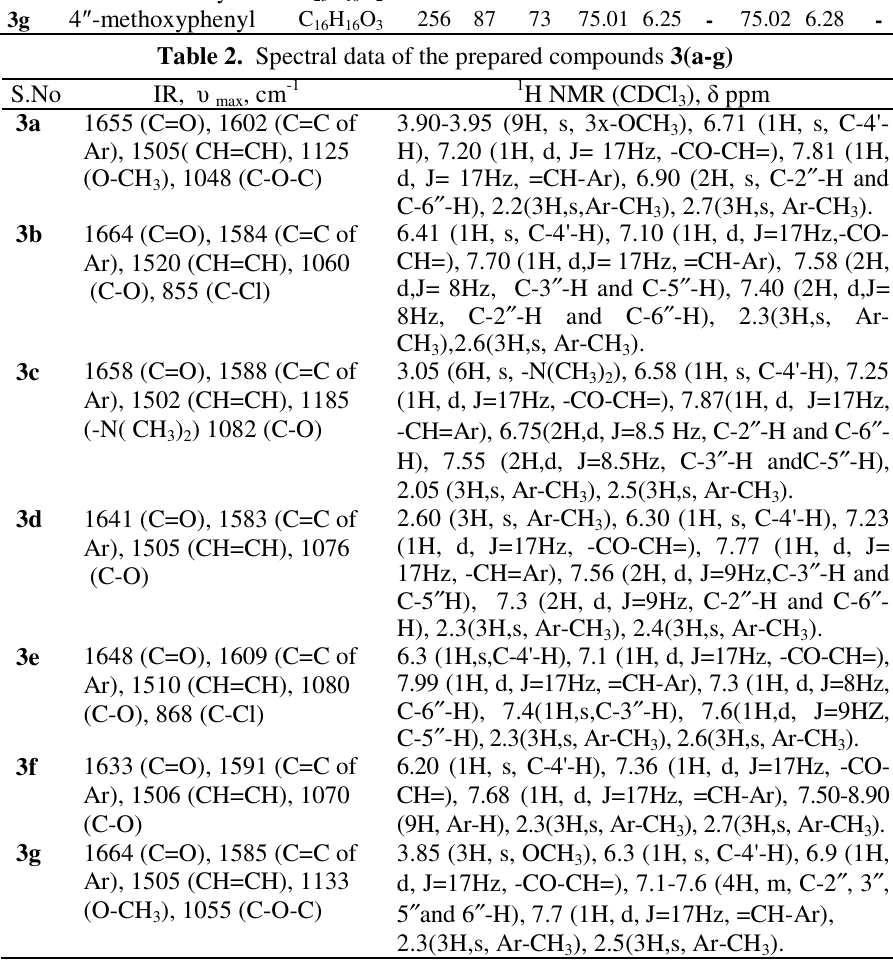
Table 2. Spectral data of the prepared compounds